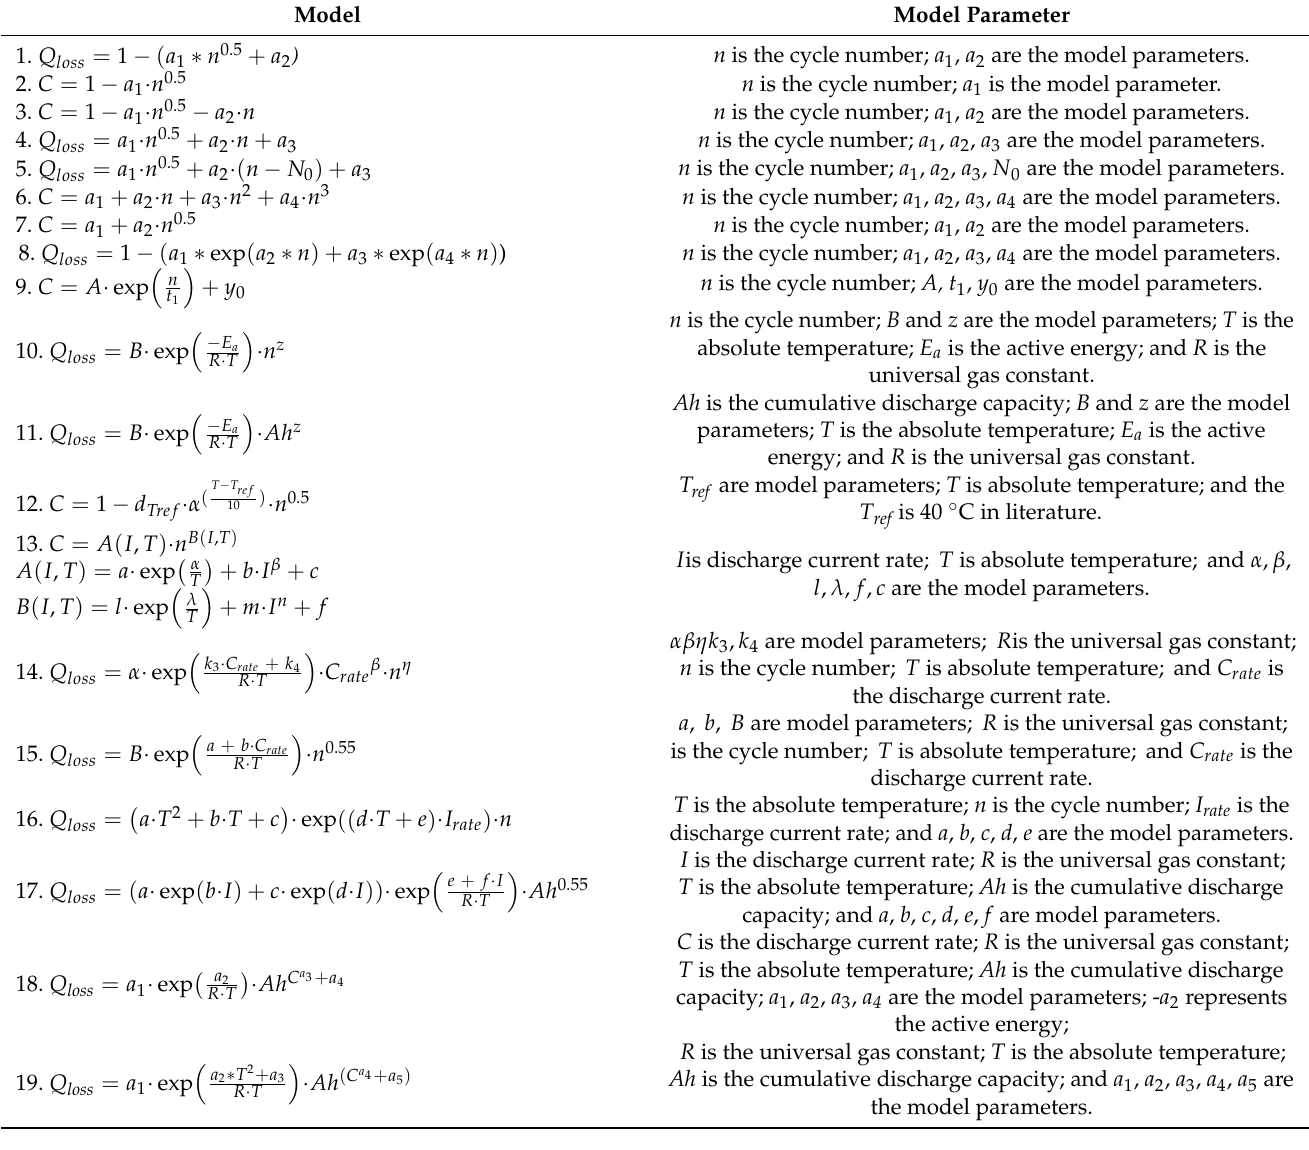
Table A1. All the parameters of the life model introduced in this